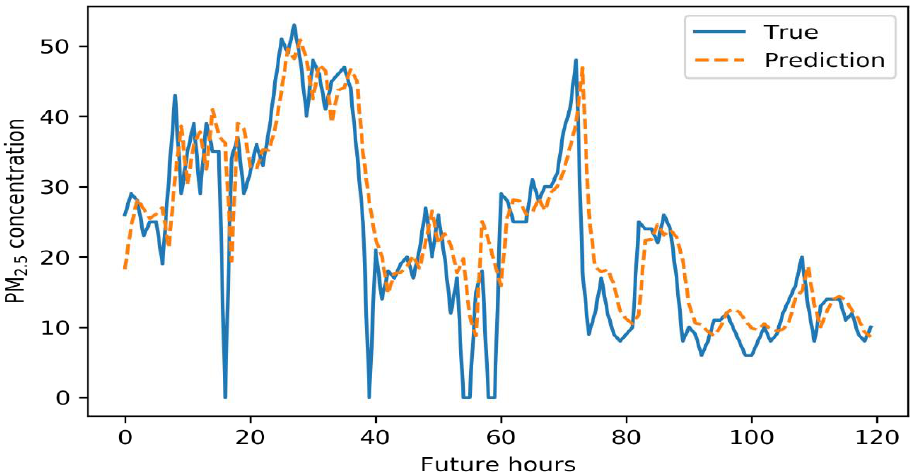
Figure 9. Five-day air pollution levels predicted by the LSTM model.